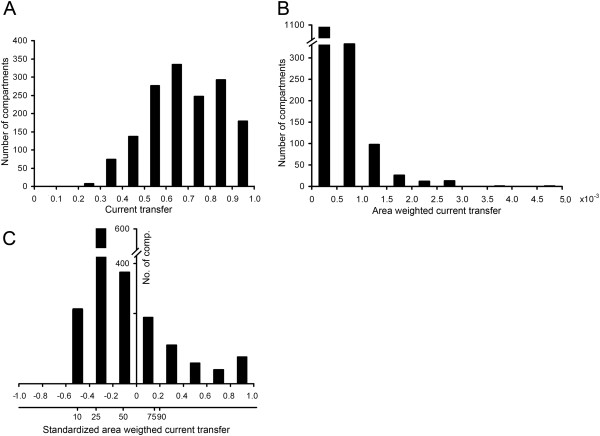
Steps of data processing to create standardized area weighted distributions of signal transfer values. Example is based on current transfers of MN C-IC82 but steps are similar for other measures of signal transfers we used. (A) Frequency distribution of somatopetal current transfers measured from mid-points of each compartment. These raw values were area weighted (B) to give proportionally bigger weight to transfers from compartments with bigger surface area. Then the area weighted distribution was standardized (C) to eliminate variable size effects of MNs on signal transfers. Shape of standardized and area weighted distribution of transfers was quantified by the 10th, 25th, 50th, 75th and 90th percentiles of the distribution (see lower horizontal axis in part C).